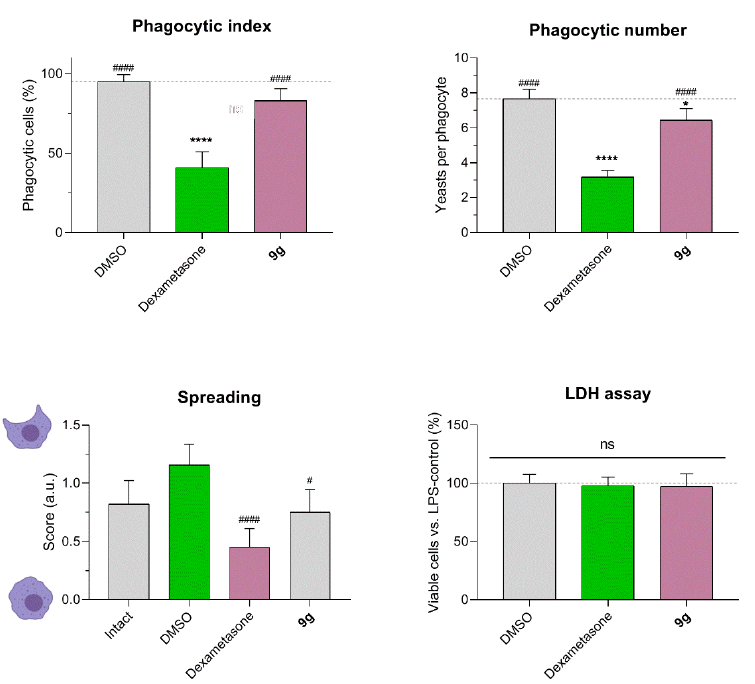
Figure 4. Effect of compounds on phagocytic activity and viability of peritoneal macrophages of mice C57bl/6j. Data are shown as mean and 95% C.I. ( n = 100); * p < 0,05, **** p < 0.0001 vs. DMSO; # p < 0,05, #### p < 0.0001 vs. dexamethasone (One-way ANOVA with Dunnett’s post-test).